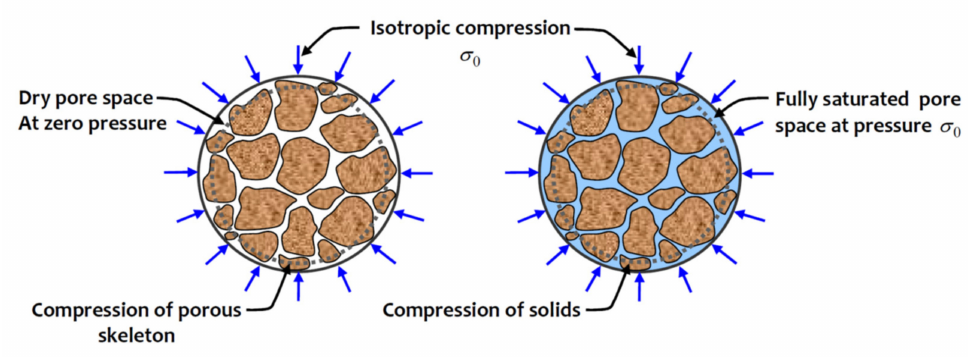
Figure 1. The experimental configurations for estimating the Biot